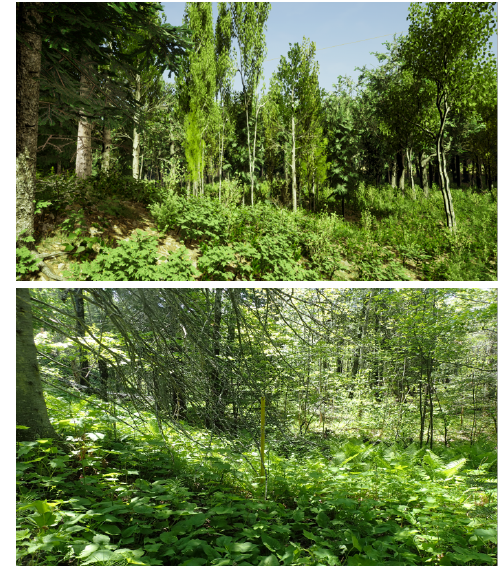
Figure 5. Top: a forest modeled based on FIA dataset without the simulation; bottom: photograph taken at the same FIA